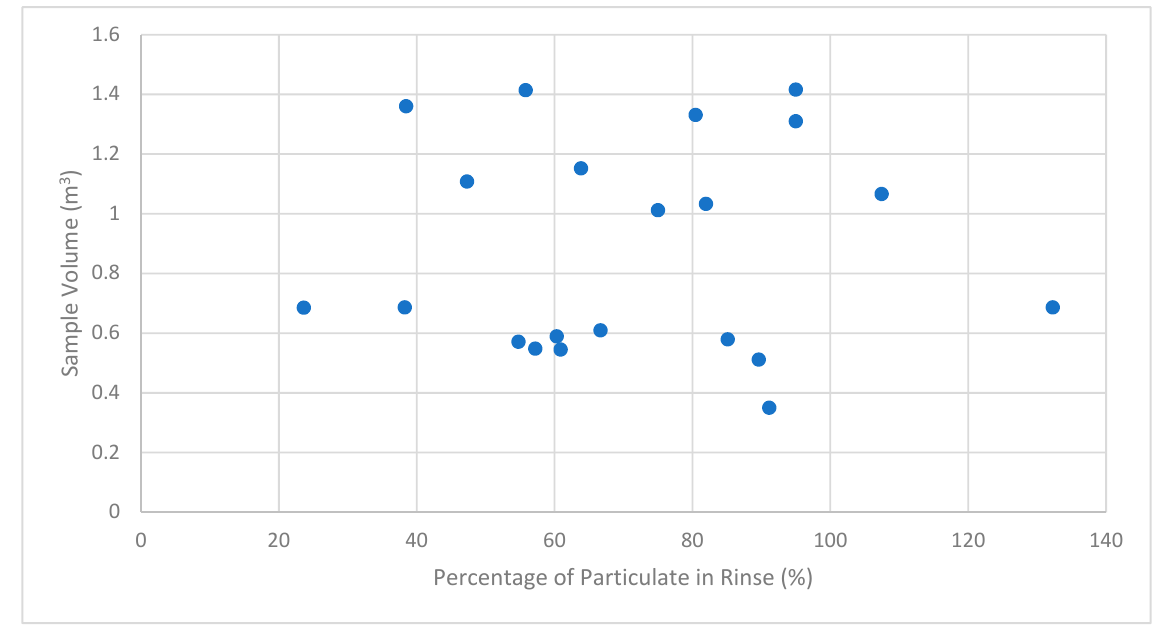
Figure 5. Sample volume vs. percentage of particulate in rinse.